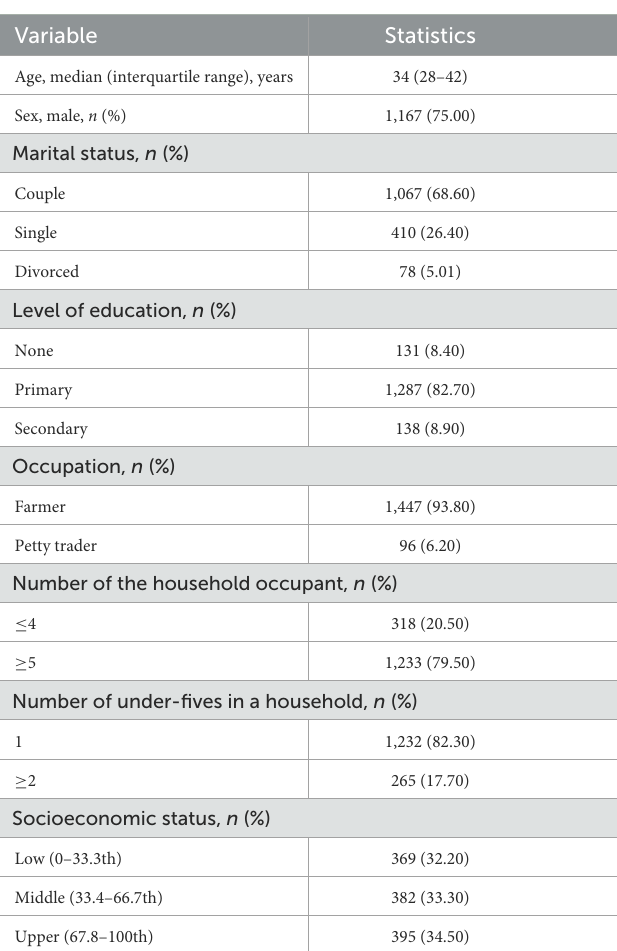
TABLE 1 Baseline characteristics of the